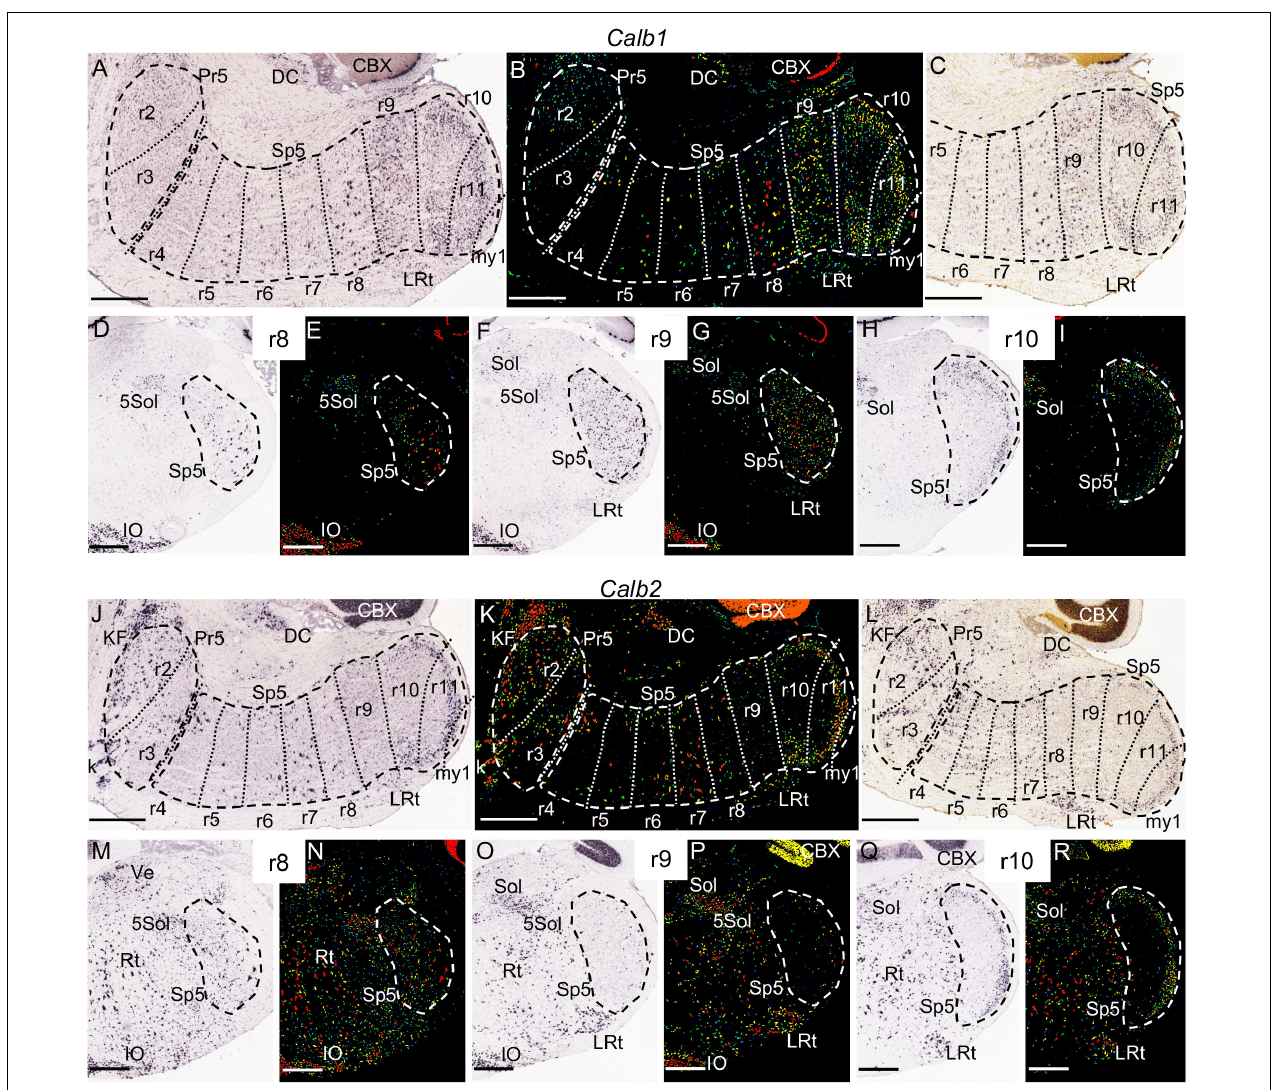
FIGURE 10 | Calb1 (A–I) and Calb2 (J–R) expression. In each image Pr5 and/or Sp5 are encircled by dashed lines. (A,B) Brightfield and color-coded images of a parasagittal section of an adult brain. There is homogenous expression in the r9 portion of Sp5, as well as a laminated pattern in r10 and r11 with higher intensity in the gelatinous layer. Additionally, there are some scattered positive in the trigeminal column across the rest of rhombomeres, principally in r8. In (A,B,J,K) the section plane would include only a small portion of my1 as commented for Figures 4A,D,E . (C) Brightfield image of a P28 parasagittal section, reproducing the aforementioned Calb1 pattern. (D–I) Pairs of brightfield and color-coded images of respective coronal sections of an adult brain at the levels of r8, r9 and r10. Besides the aforementioned pattern in the trigeminal column, in these section planes there is expression in the inferior olive (IO), the solitary nucleus (Sol), the trigeminal-solitary transition zone (5Sol) and part of the lateral reticular nucleus (LRt). (J,K) Brightfield and color-coded images of a parasagittal section of an adult brain processed for detection of Calb2 expression. There is expression in the r10 and r11 portions of Sp5, showing a laminated pattern with higher intensity in the gelatinous layer, together with medium-high intensity in r2 and r3, and scattered positive cells from r4 to r8. (L) Brightfield image of a P28 parasagittal section, reproducing the aforementioned Calb2 pattern. (M–R) Pairs of brightfield and color-coded images of respective coronal sections of an adult brain at the levels of r8, r9 and r10. Note the absence of Calb2 expression in r9, as compared to scattered cells in r8 and a laminar pattern in r10. There is also expression in the inferior olive (IO), the solitary nucleus (Sol), the trigeminal-solitary transition zone (5Sol), the lateral reticular nucleus (LRt) and other parts of the medullary reticular formation (Rt). Scale bars = 500 µ